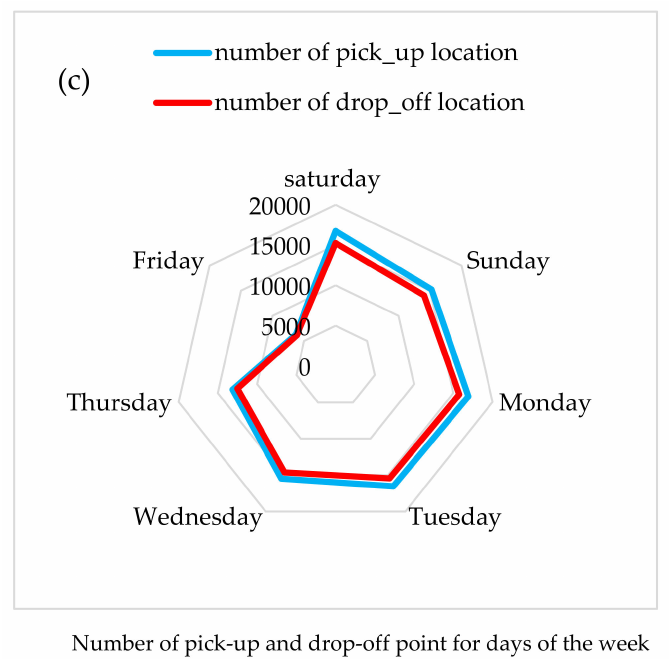
Figure 4. The pick-up and drop-off locations statistics in the different time scales. On a daily scale, a similar pattern and an almost equal number of pick-up and drop-off locations per day are examined. On a weekly scale, Fridays and Thursdays depict lower numbers than the rest of the days of the week. Expectedly, statistics indicate taxi travels are lower at weekends and that a similar pattern is examinable across all weekdays. On an hourly scale, results depict different spatial distribution patterns at different hours per day. With the working hour beginning in the morning, the rush hour rises from 8:00 to 9:00. Besides, from 14:00 to 15:00, when the daily work is completed and the passengers return to their homes, another rush period is expected. There is also a reduction in the